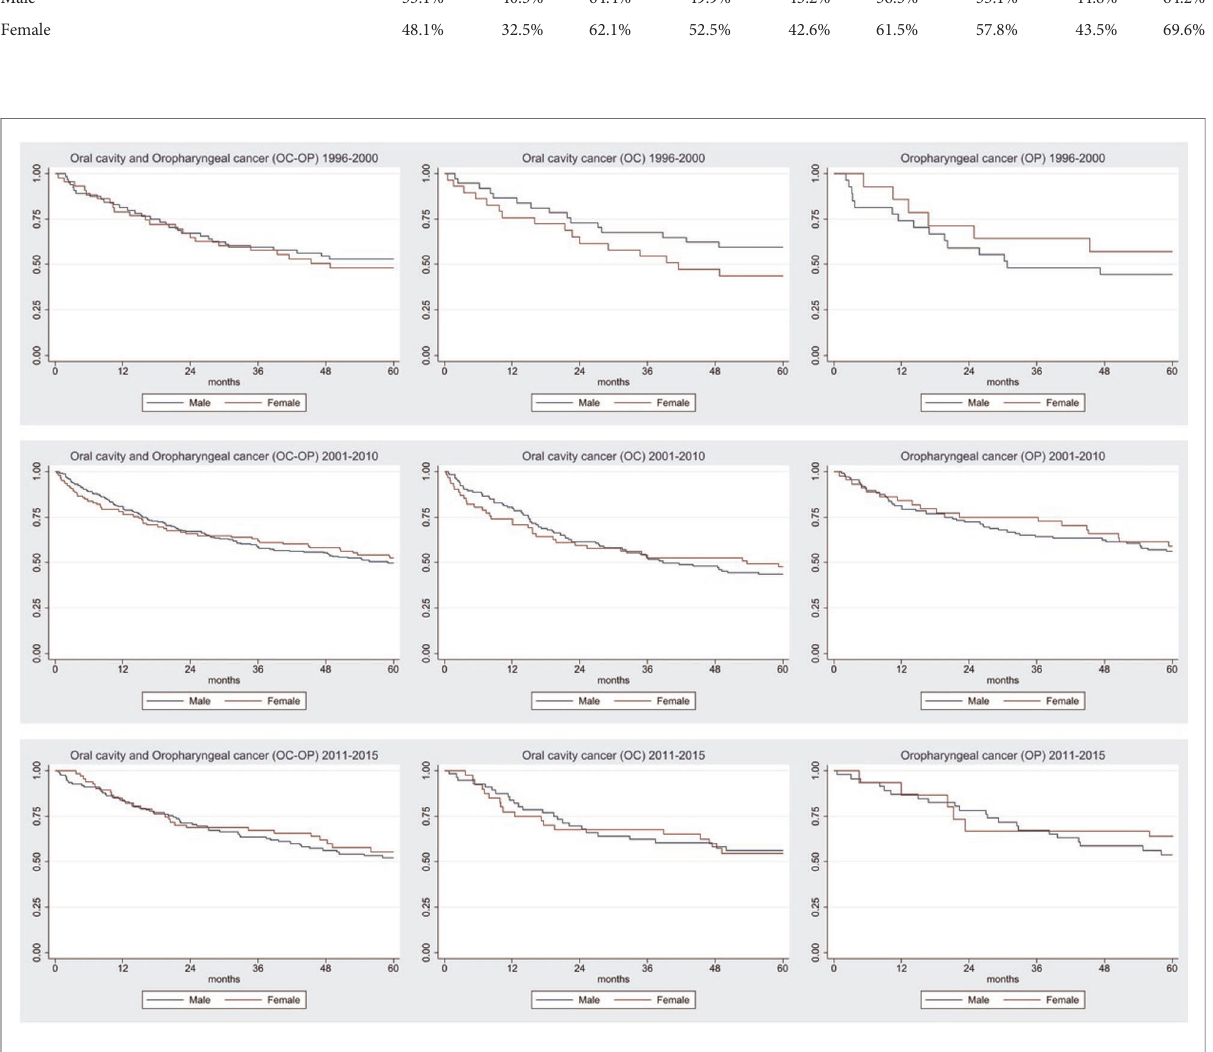
FIGURE 2 Five-year survival by subtype and sex in three different periods.